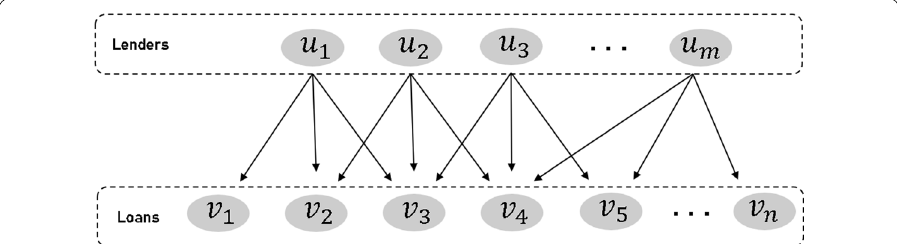
Fig. 2 Bipartite investment network (The top side represents the lenders, the bottom side represents the loans, and the middle line represents the investment relationship between the lenders and